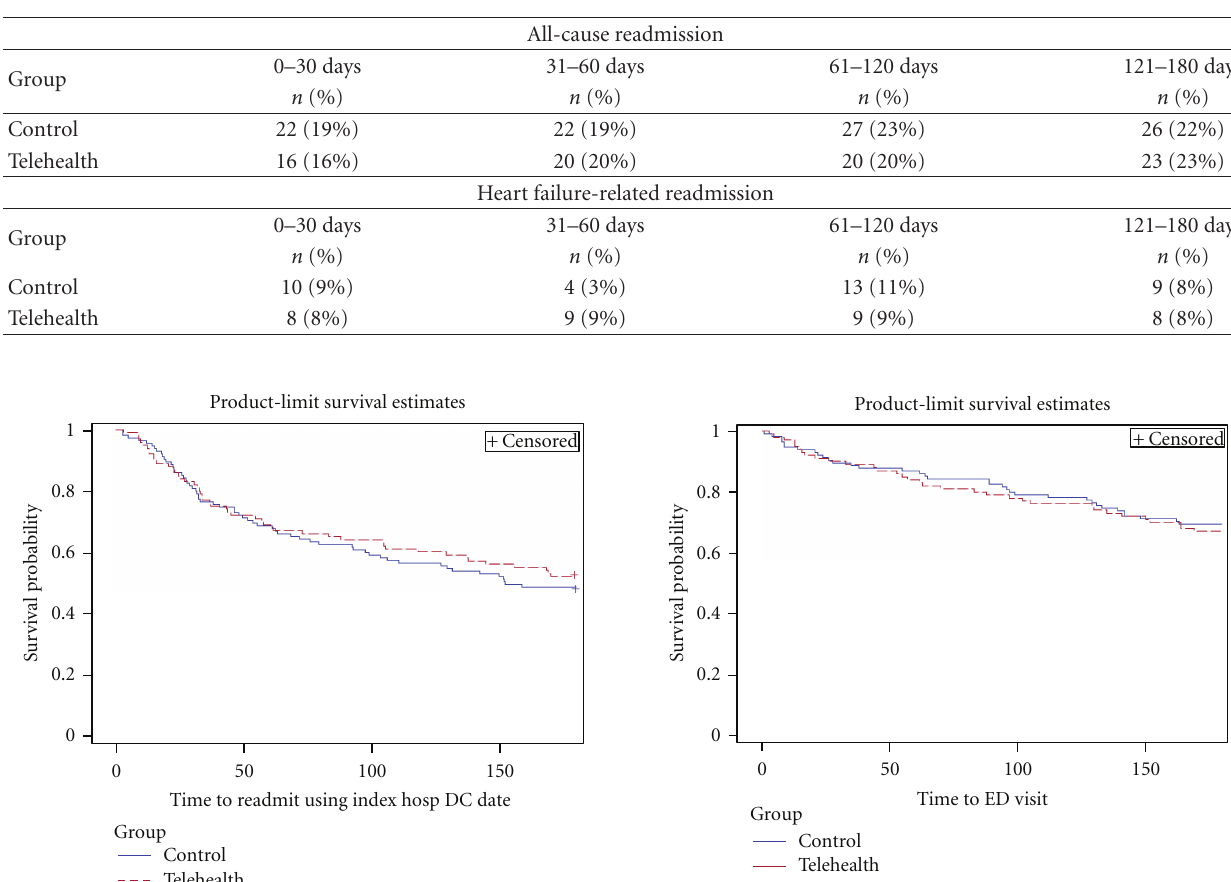
Table 4: Number and percentage of readmissions by time period and group.